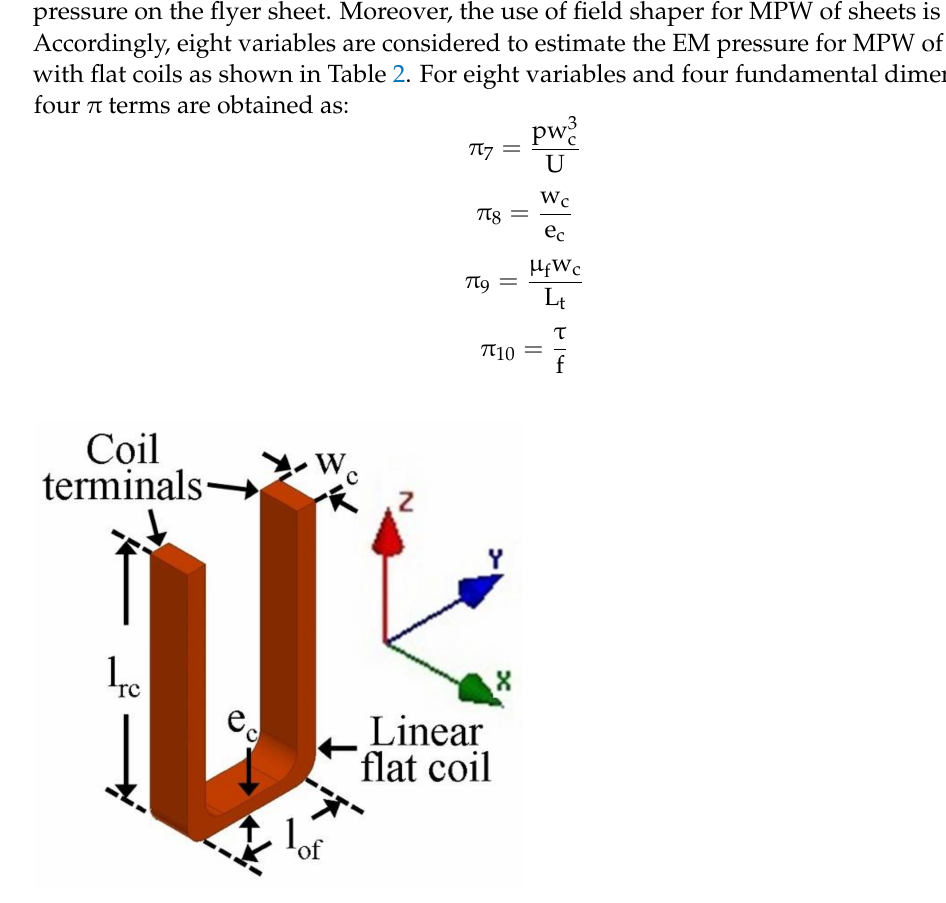
Figure 2. Schematic geometry and dimensions of a flat linear coil for MPW of sheets. Table 2. Variables and their corresponding dimensions in the MLTI system for dimensional analysis of the EM pressure for MPW of